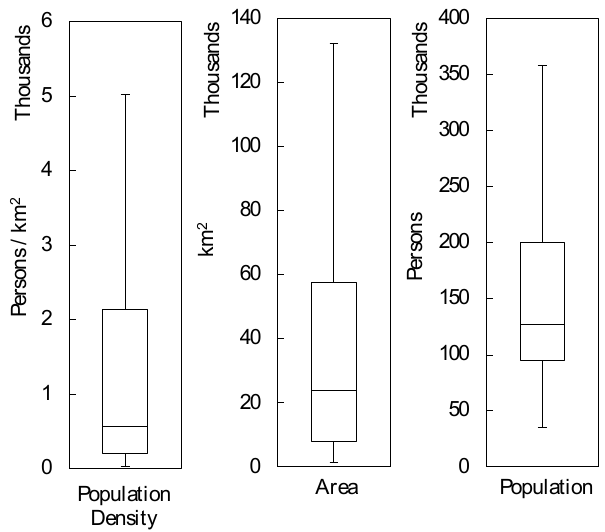
Figure 1. Bar charts summarizing the population, population density, and area characteristics of the 346 local authority units extracted from ONS 2011 Census data [30].